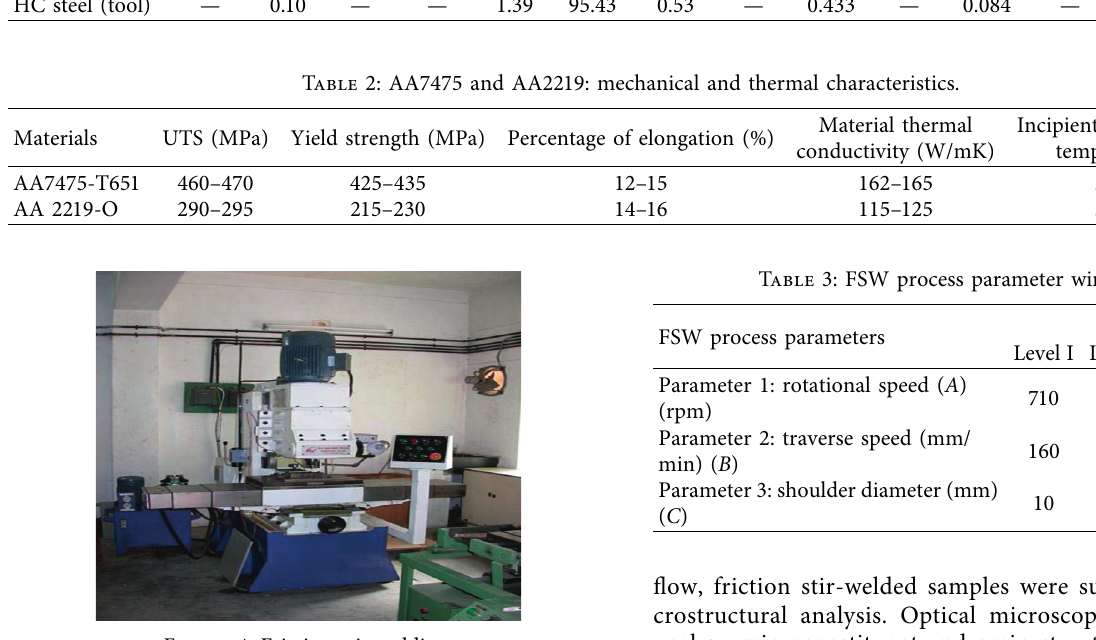
Figure 4: Friction stir welding.